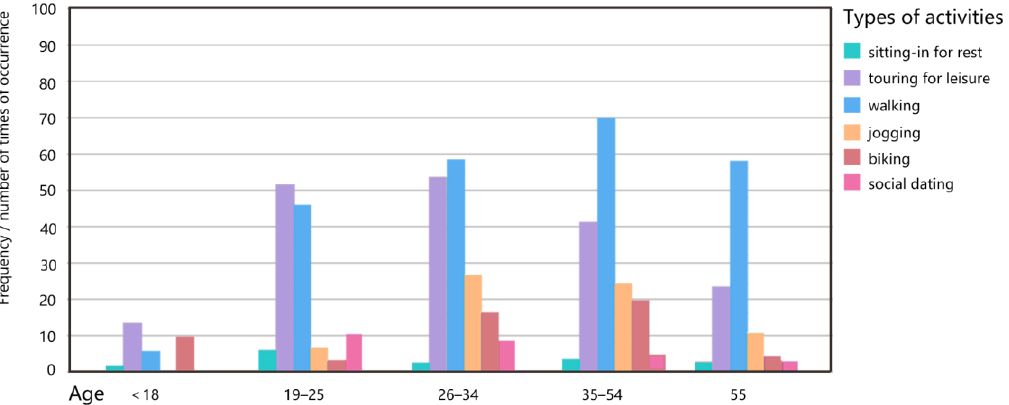
Figure 14. Frequency distribution of interviewees of different ages and their preferred activities.